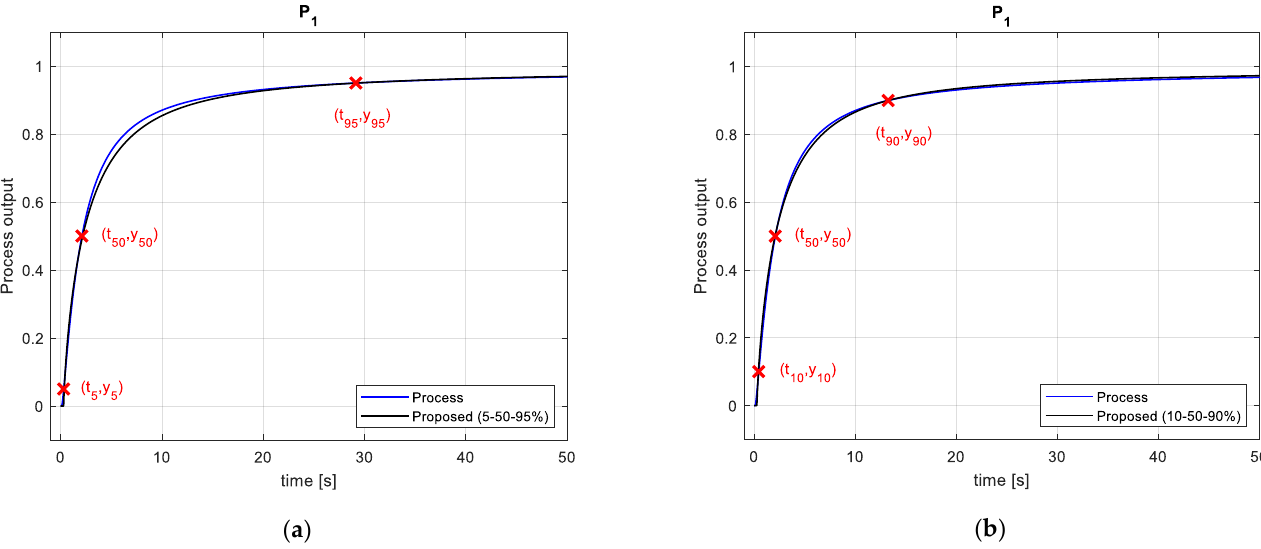
( b ) Figure 9. FFOPDT model step response using the proposed identification method for process P 1 and process reaction curve: ( a ) Symmetrical set of points (25-50-75%); ( b ) Asymmetrical set of points (10- 55-90%).